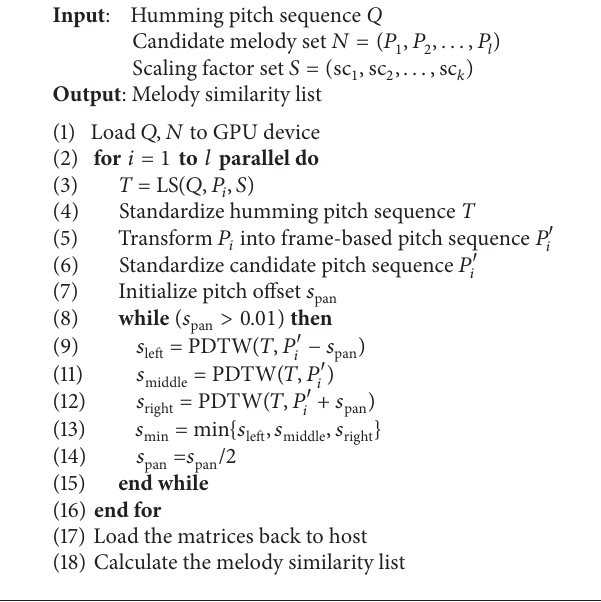
Algorithm 3: GPU-based parallel melody accurate matching.